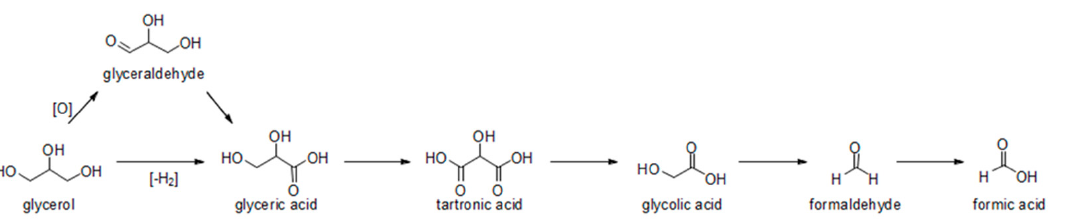
Figure 25. The scheme of glycerol oxidation with oxygen in liquid phase. Reproduced with permis- sion from ref. [224] Copyright © 2009 Elsevier